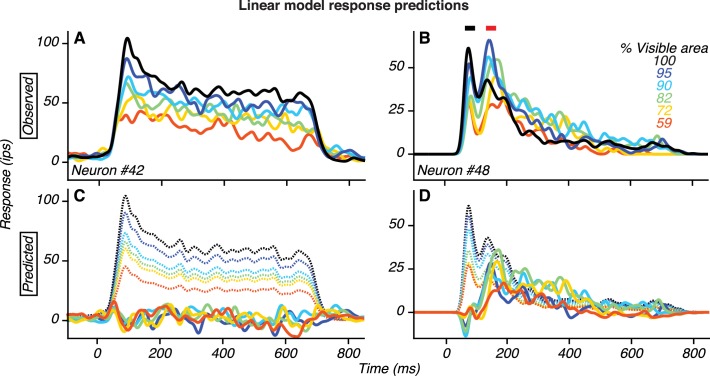
Analysis of V4 response dynamics across occlusion level.(A) Responses of an example neuron with two peaks (same data as in Figure 4B). (B) Responses of an example neuron without two peaks (same data as in Figure 4D). (C–D) Response predictions of a linear model (dotted lines) and the residuals (solid lines), derived from the responses in (A–B), as described below. Responses to stimuli at different occlusion levels were modeled as gain modulations of responses to unoccluded stimuli (black lines) using the following equation. r(u,t)=k(u)×r(u=100,t) where r is the response as a function of occlusion level u and time t. k is a scalar value that specifies the response gain. For each occlusion level, we estimated k using a linear regression between the responses to occluded and unoccluded stimuli in the interval 65–150 ms. For the V4 neuron whose responses are shown in A, the predicted responses provide a good match to the observed responses and the residuals are low. This implies that the neuron’s temporal response profile is similar across occlusion levels up to a multiplicative scale factor, and that the dynamical response has a stereotypic trajectory with a single input parameter k(u). This result suggests that the dependence of this neuron’s responses on occlusion level is governed by its earliest input signals and that this relationship is stationary during the test stimulus epoch. For the V4 neuron whose responses are shown in (B), the predicted responses do not provide a good match to the observed data. The residuals are large and positive: they reach a maximal value around 150 ms, and are strongest for intermediate occlusion levels. Thus, a good minimal description of the dynamical response trajectories can be obtained by including an additive term that is stronger for occluded than unoccluded stimuli. Specifically. r(u,t)=k(u)×r(u=100,t)+f(u,t) where f(u,t) is given by the residual (in D). This result is consistent with the possibility that the additive input given by f(u,t) is derived from vlPFC inputs because f(u,t) emerges (~150 ms) after response onset in roughly half the PFC neurons, and that f(u,t) is stronger for responses to occluded than unoccluded stimuli as in vlPFC.